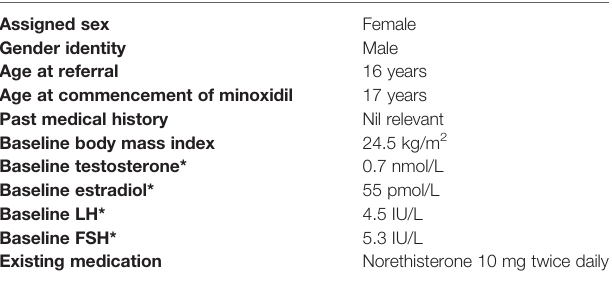
TABLE 1 | Patient